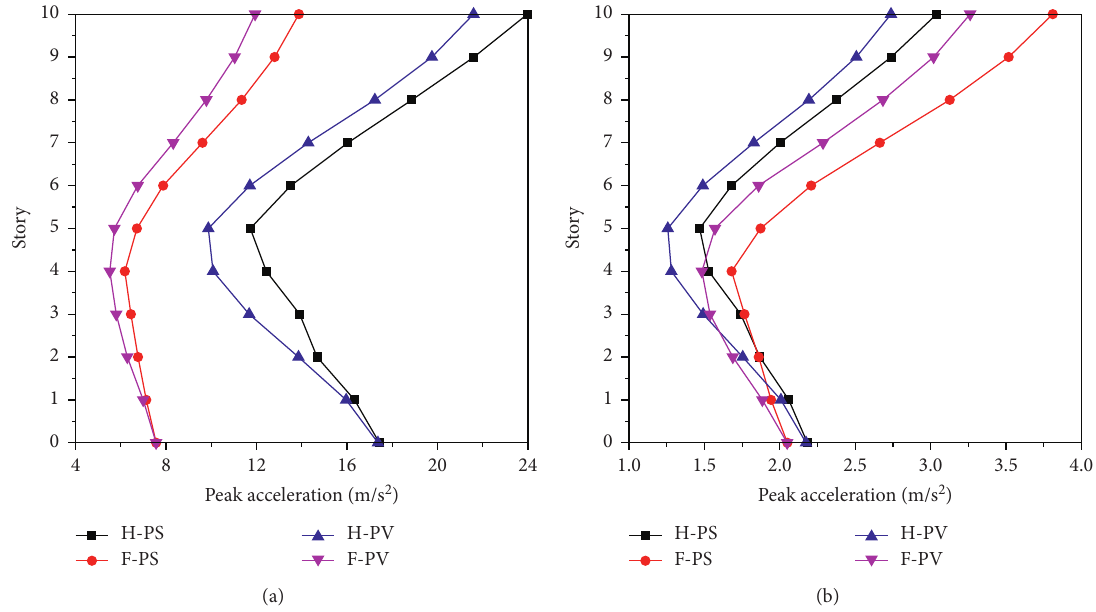
Figure 6: The average peak acceleration of the structure under the hanging wall and footwall seismic excitations: (a) without amplitude modulation; (b) with amplitude modulation. Note. H: hanging wall; F: footwall; PS:10-story structure supported by pile group foundation on soft soil; PV: 10-story structure with viscous dampers supported by pile group foundation on soft soil.